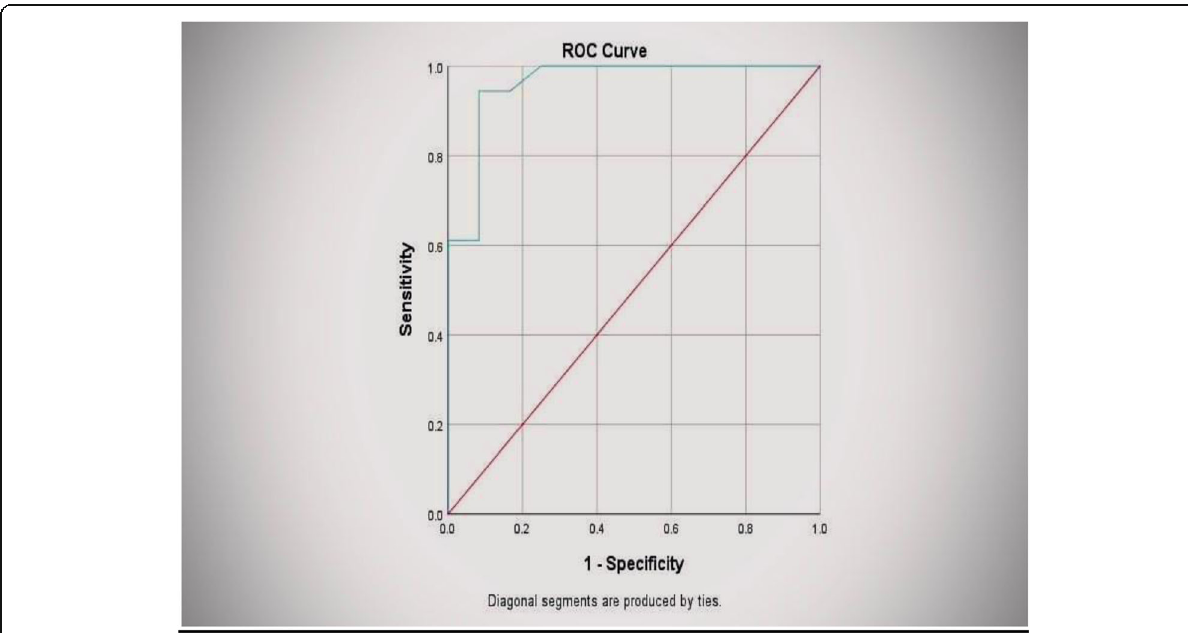
Fig. 8 Receiver – operating characteristic (ROC) curve analysis. The ROC curve analysis shows that the apparent diffusion coefficient (ADC) cutoff value of 1.43 × 10 − 3 mm 2 /s was the most accurate for predicting the nature of the suspicious lesions, with an area under the curve of 0.961, a sensitivity of 94.4% and a specificity of